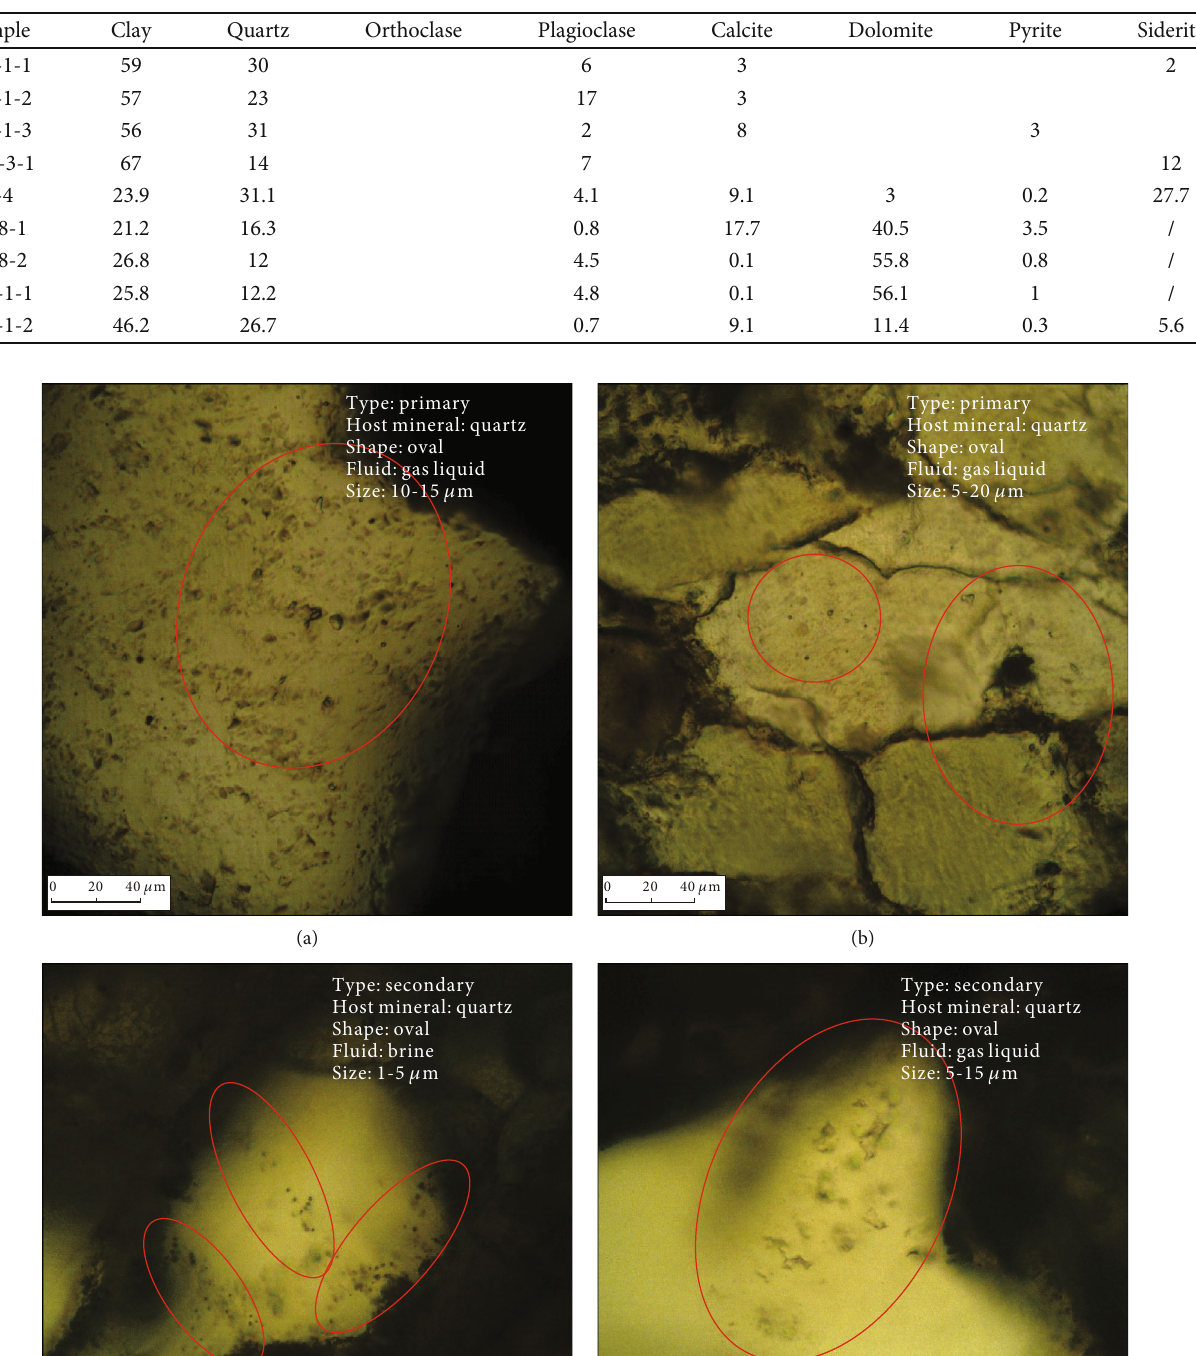
Table 2: The mineral composition contents of the Longtan sandstone samples in west Guizhou based on X-ray di ff raction analysis.